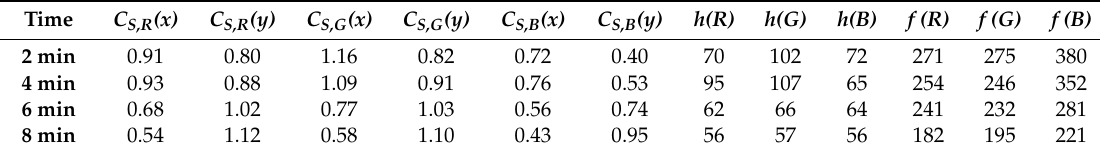
Table 1. Statistical data of tea image energy clustering training at different fixation times.